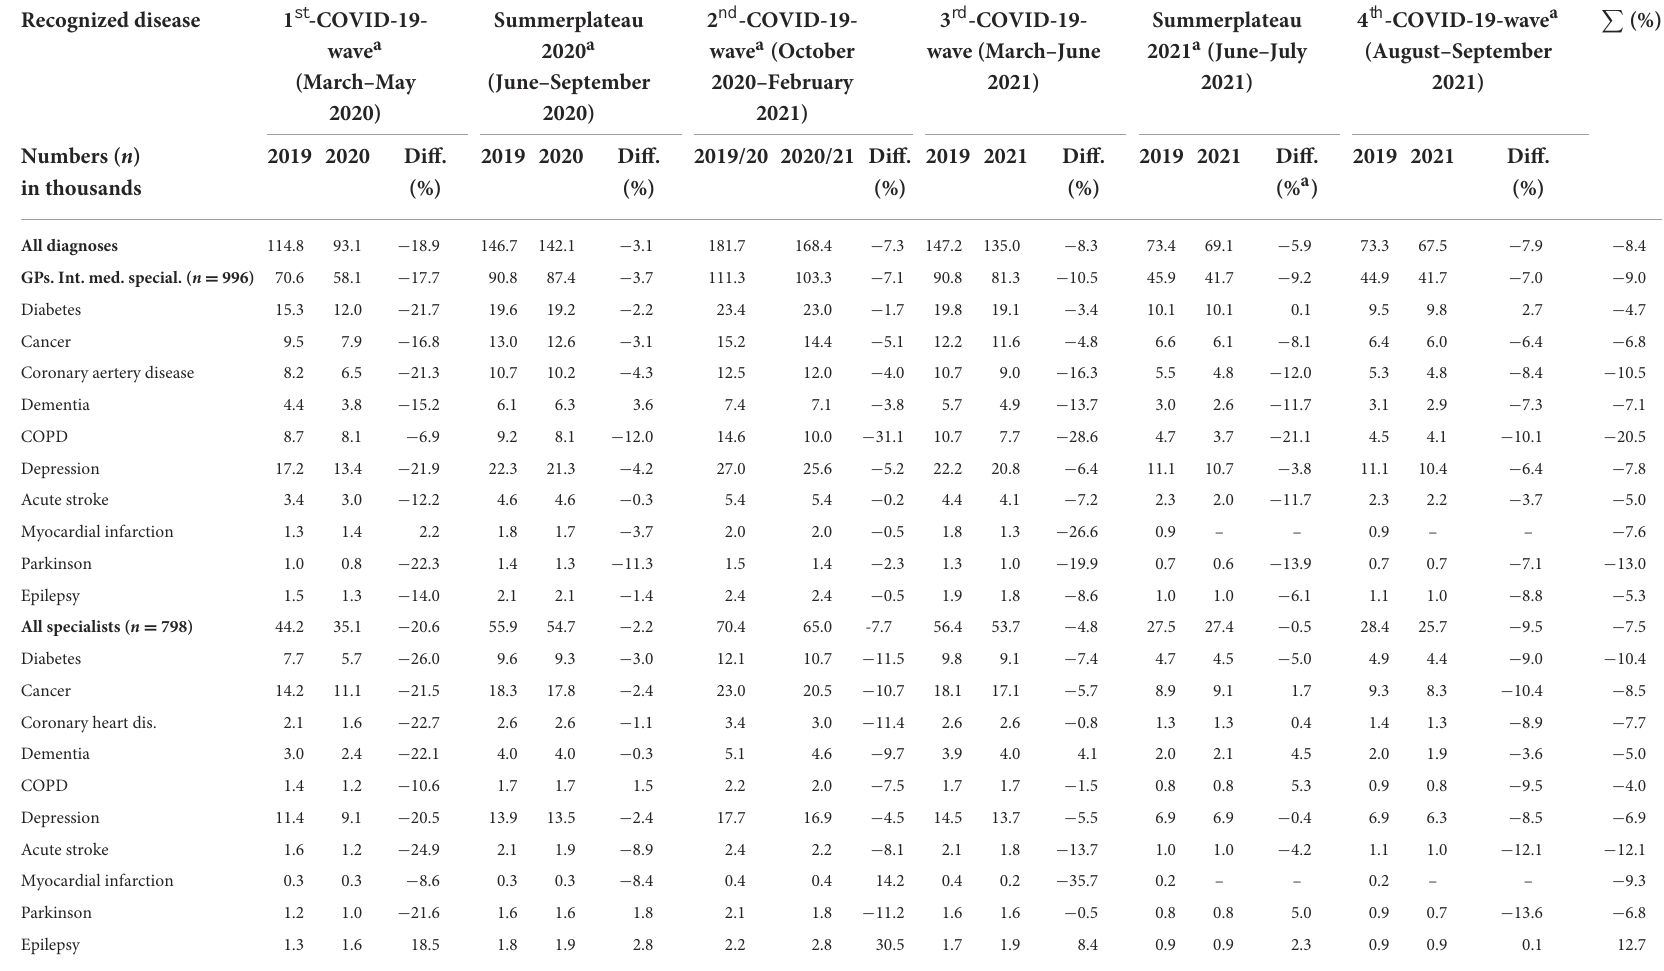
TABLE 2 Recognition of diseases during the COVID-19 pandemic in Germany compared to the pre-pandemic time frame 2019/20. Recognized disease 1 st -COVID-19- wave